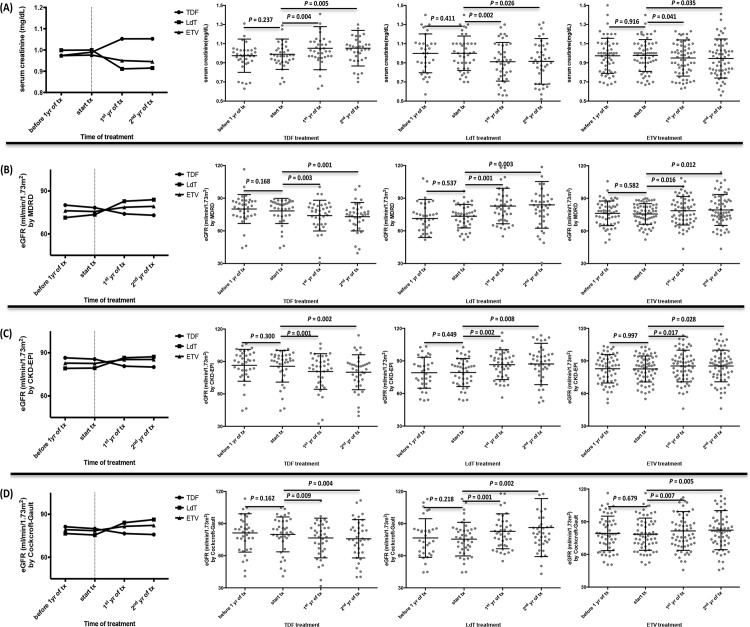
Changes of renal function-associated indicators among tenofovir, telbivudine and entecavir groups before and after treatment.(A) by serum creatinine (B) eGFR calculated by MDRD (C) eGFR calculated by CKD-EPI (D) eGFR calculated by Cockcroft-Gault. Horizontal bar indicates mean levels with standard deviation.